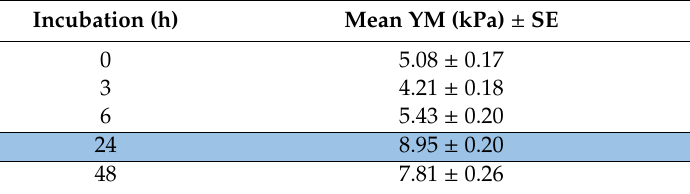
Table 1. Temporal variation of Young’s modulus mean values for MCF-7 cells upon exposure to 50 µ M resveratrol. The blue box highlights extreme values obtained at t = 24